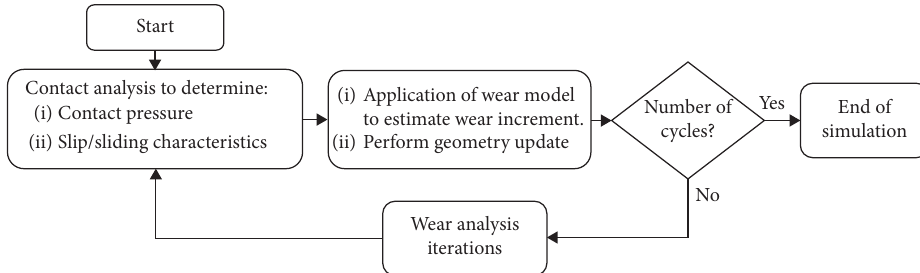
Figure 1: Flow chart depicting typical wear simulation